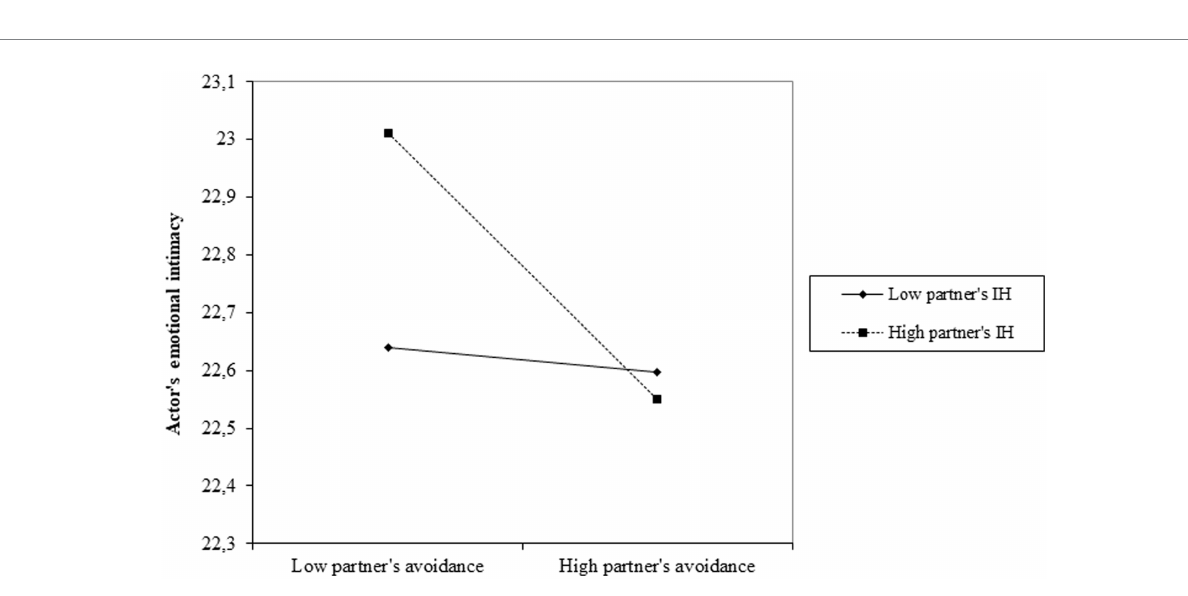
FIGURE 2 The association of partner’s attachment avoidance with actor’s emotional intimacy as a function of partner’s internalized homonegativity